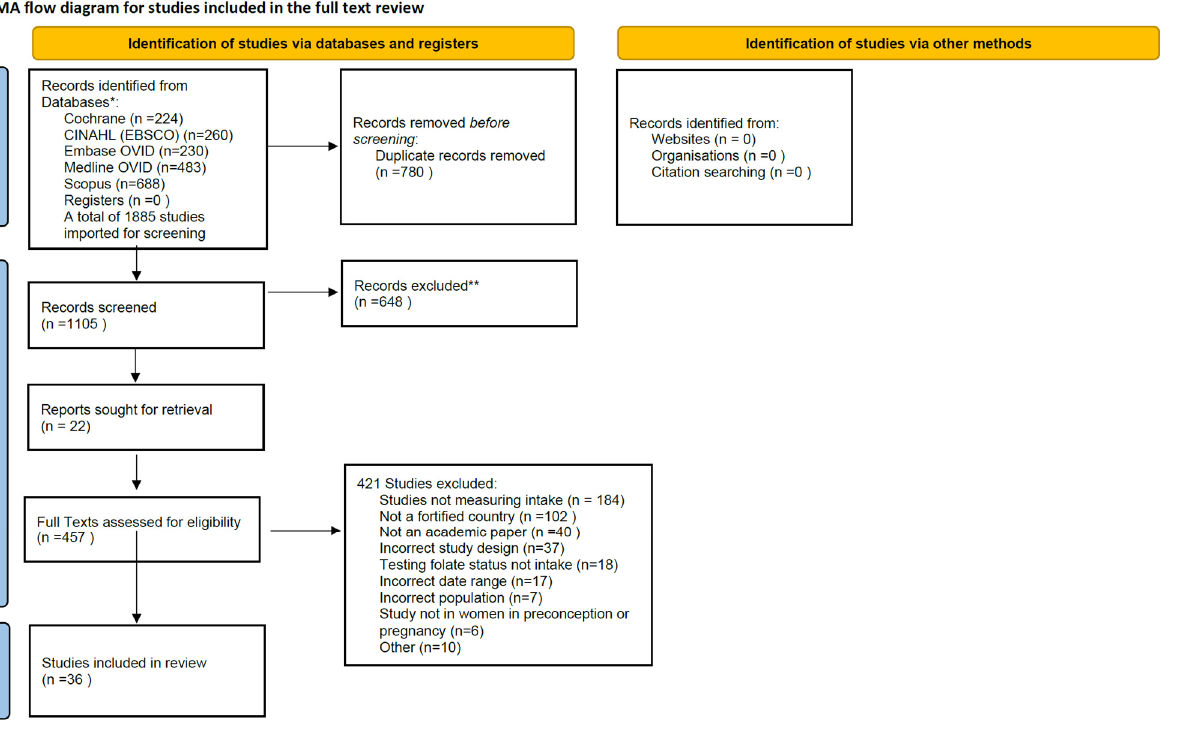
Figure 4. PRISMA-P flowchart of study selection [70]. Quality Assessment of Study. * p < 0.01; ** p <